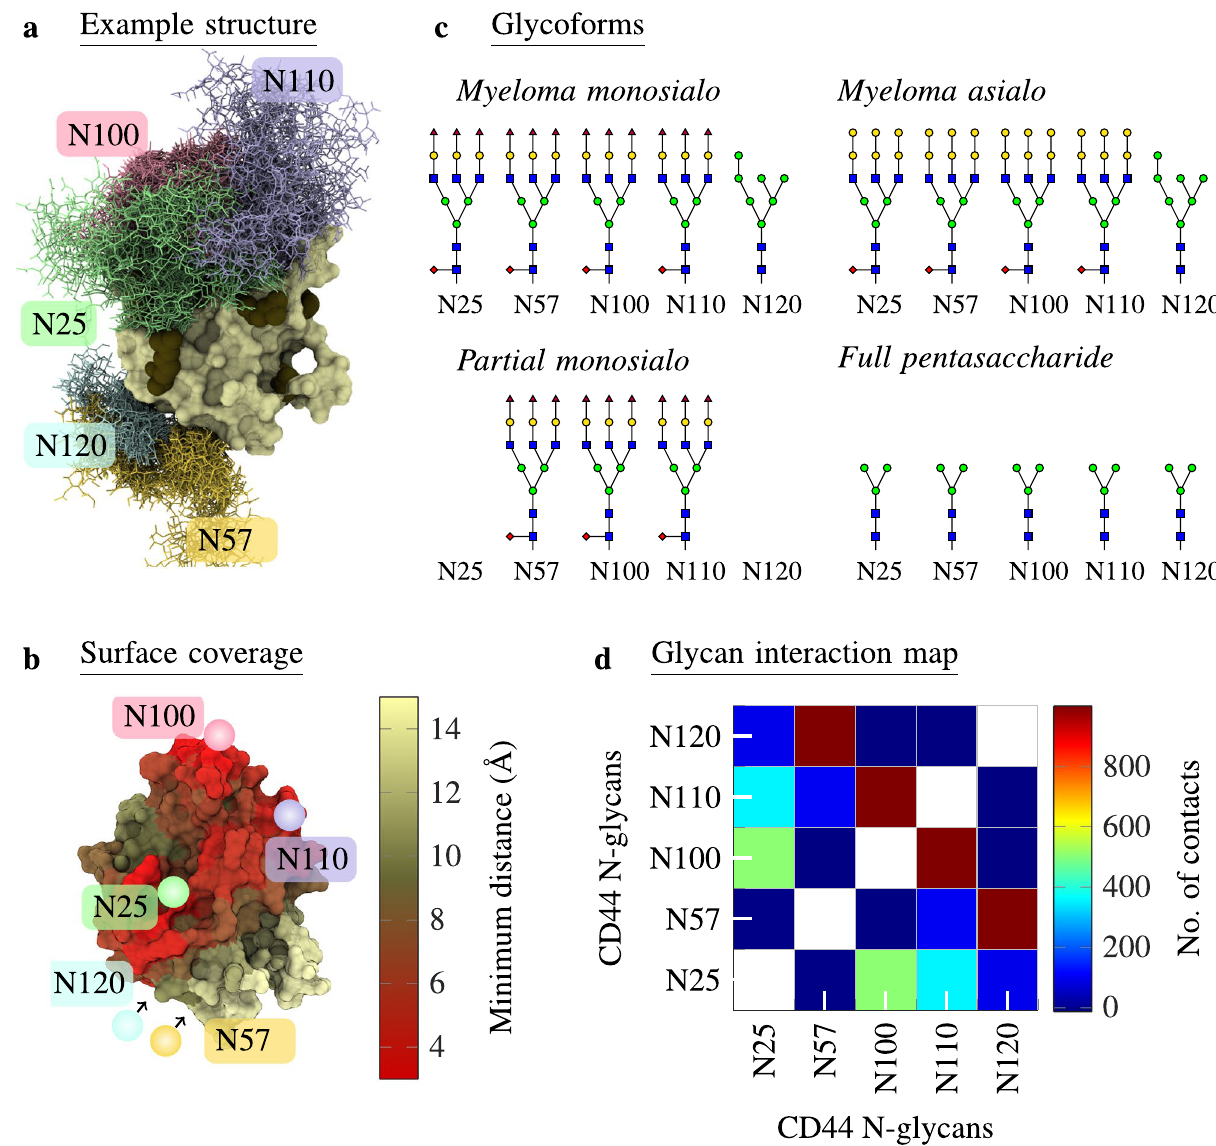
Figure 2. ( a ) Example structure of CD44-HABD with the myeloma monosialo glycoform (system G2 in Table 2). CD44-HABD is colored pale, and different colors separate the glycans. Glycans are depicted at every 50 ns in a trajectory of 1000 ns. ( b ) CD44-HABD with the surface colored according to the minimum distance to the N-glycans (not shown). Pale color corresponds to CD44–N-glycan distances over 15 Å, whereas bright red corresponds to distances less than 3 Å. The distance data have been averaged over 15 replicas ( myeloma monosialo glycoform). ( c ) Glycoforms used in this study. The symbols follow the Symbol Nomenclature for Graphical Representations of Glycans 36 . ( d ) Number of contacts (defined as distance < 0.6 nm) between the five N-glycans on CD44-HABD ( myeloma monosialo glycoform). The results have been averaged over time and 15 replicas. Another simulation force field (CHARMM36) in Notes SC and SD shows consistent